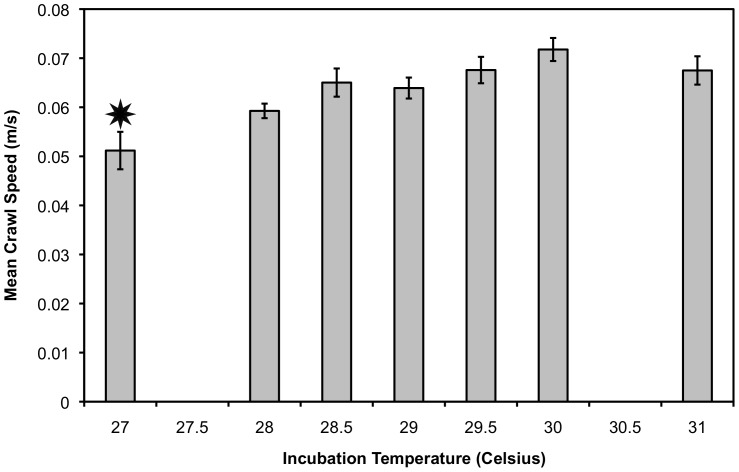
Mean crawl speed for the third crawl (C3) ± S.E.M. in 2011, with hatchlings from 27°C (starred) being significantly slower than all other hatchlings (F2,6 = 3.979, p<0.01).This trend is seen for C1 and C2 as well, but the effect of incubation temperature is not detectable statistically. [Sample size: 27°C n = 5; 28°C n = 5; 28.5°C n = 12; 29°C n = 15; 29.5 n = 11; 30°C n = 6; 31 n = 3].